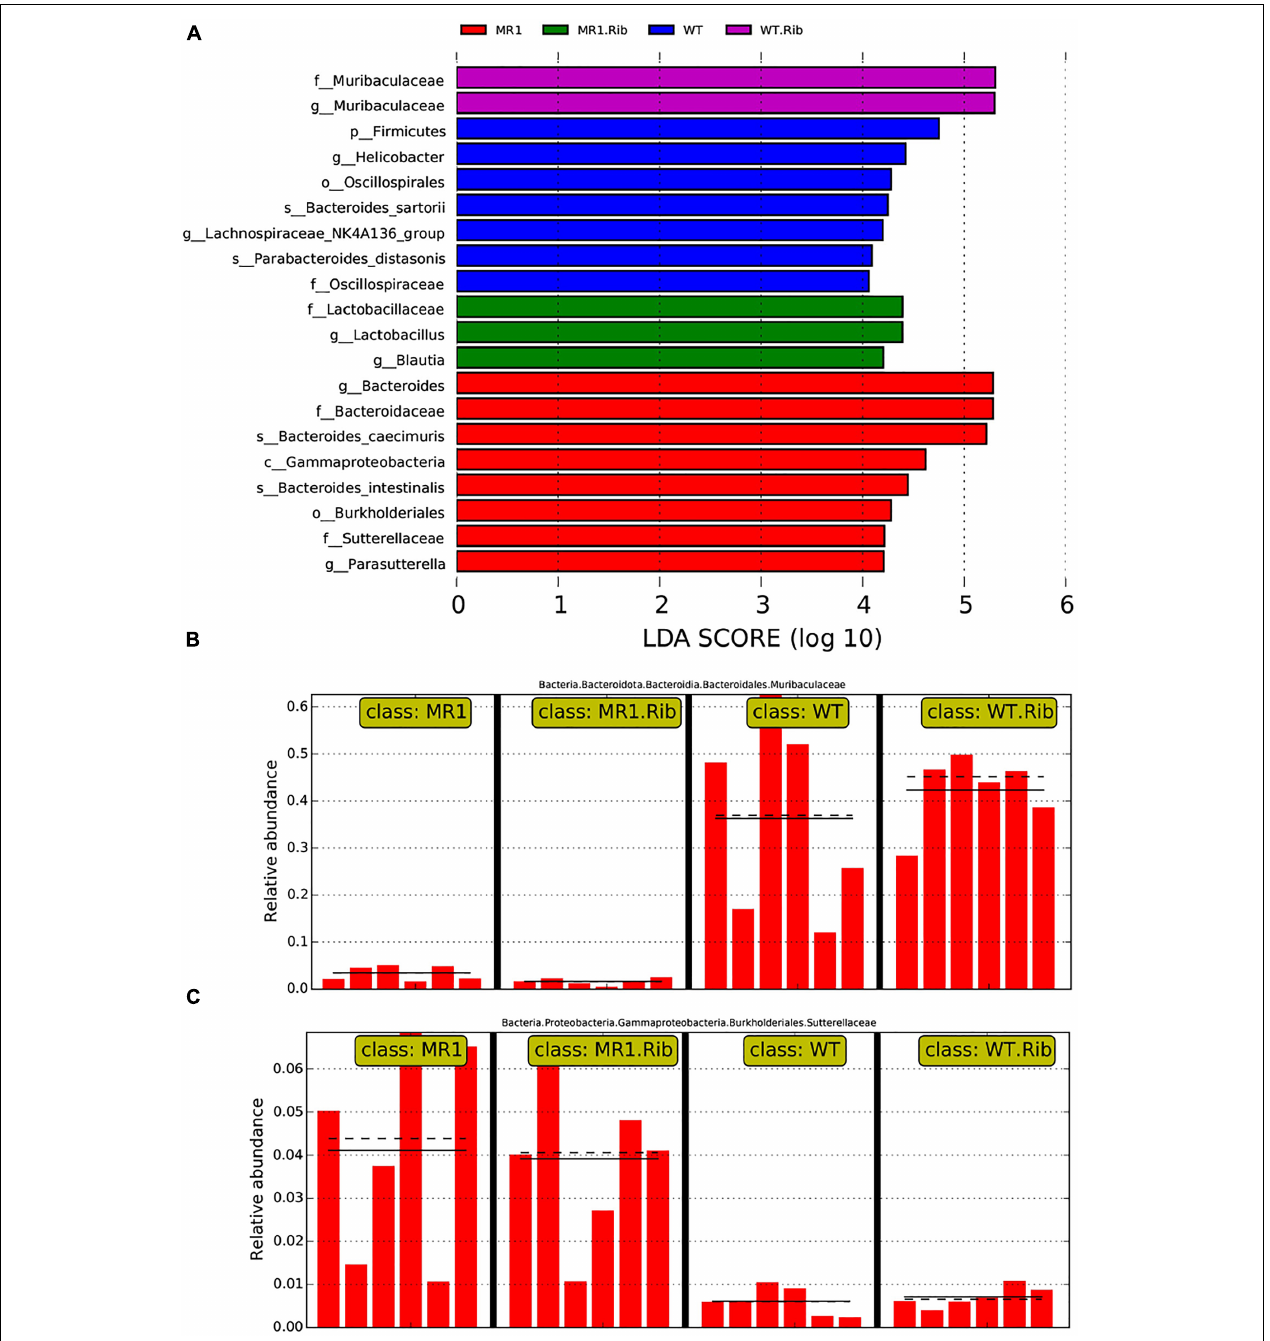
FIGURE 5 | Biomarkers showing significant differences in species with latent Dirichlet allocation (LDA) scores greater than four between groups. The bar chart shows the distribution of the LDA values. (A) The bars represent species showing significant differences in abundance between different groups, and the length of the bars represents the magnitude of the effect of the species showing differences in abundance. Analysis of Muribaculaceae (B) and Sutterellaceae (C) in the different